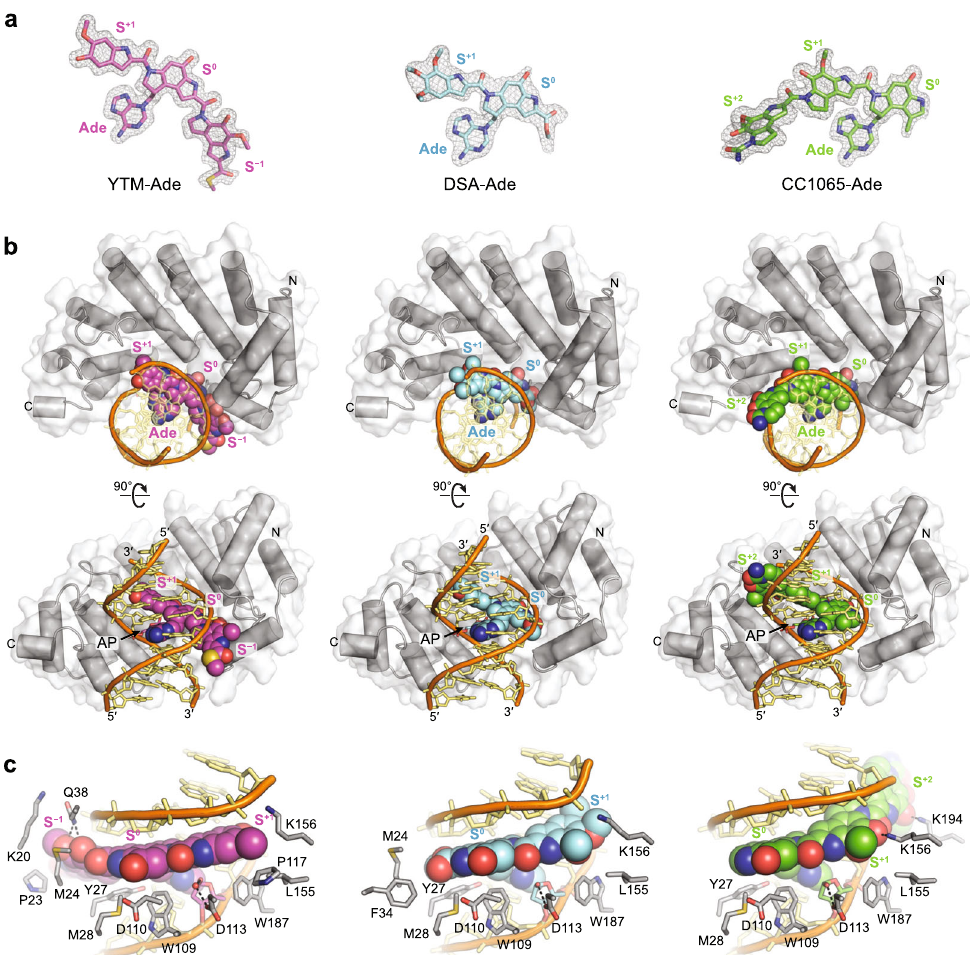
Fig. 5 Comparison of AlkD product complexes. a Excised SCPCHD adducts from the crystallographic AlkD product complexes. Annealed omit m F o − D F c electron density maps are contoured to 3 σ and carved around the omitted atoms with a 2 Å radius. b Orthogonal views of AlkD in complex with AP-DNA and either YTM-Ade (magenta), DSA-Ade (cyan), or CC1065-Ade (green). c Close-up views of the AlkD product complexes showing all residues that interact with the SCPCHD adducts. Hydrogen-bonding interactions are indicated with dashed lines. The structure of AlkD bound to AP-DNA and YTM-Ade (PDB accession 5UUG) was previously described by Mullins et al. 18